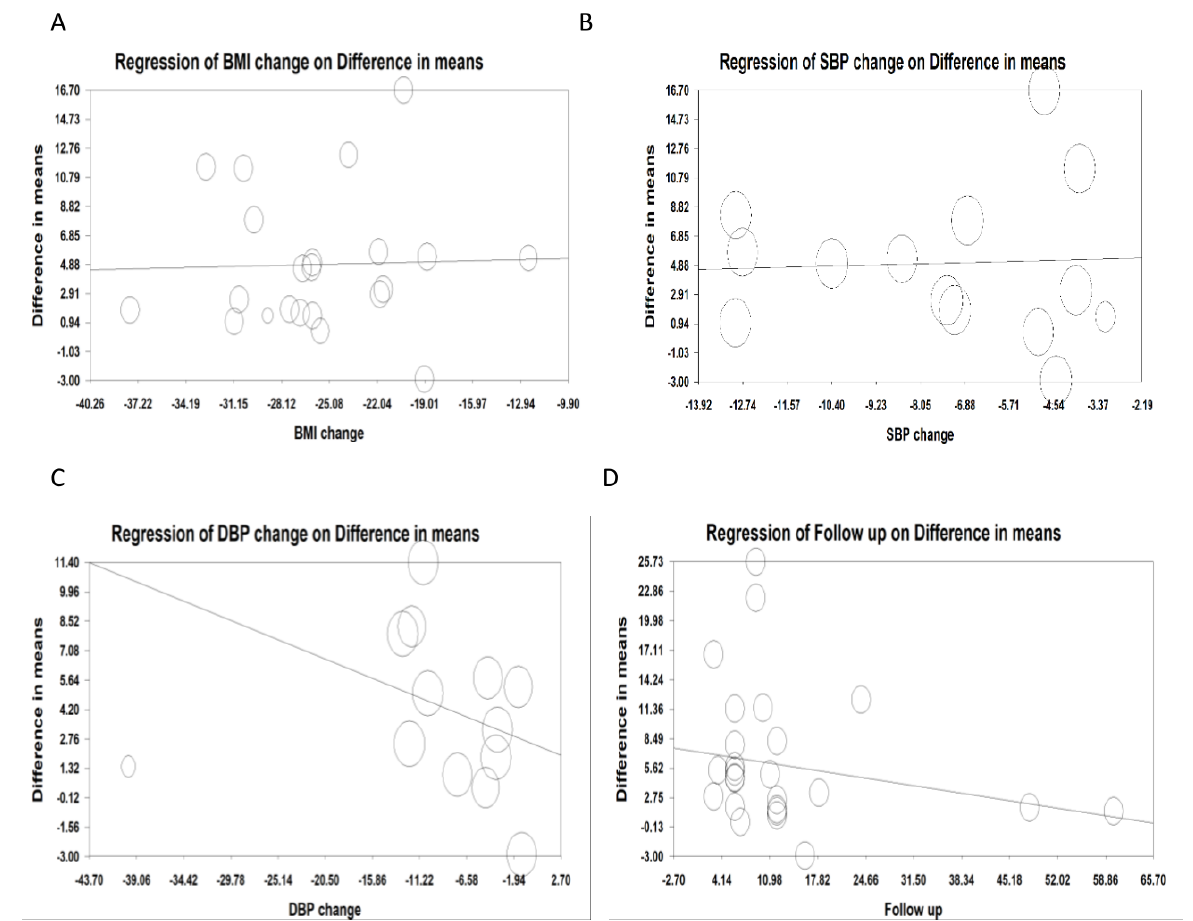
Figure 5. Random-effects meta-regression for evaluating the effect of: ( A ). BMI change (in 842 sub- jects); ( B ). SBP change (in 500 subjects); ( C ): DBP change (in 500 subjects); ( D ): follow up duration (in 891 subjects).